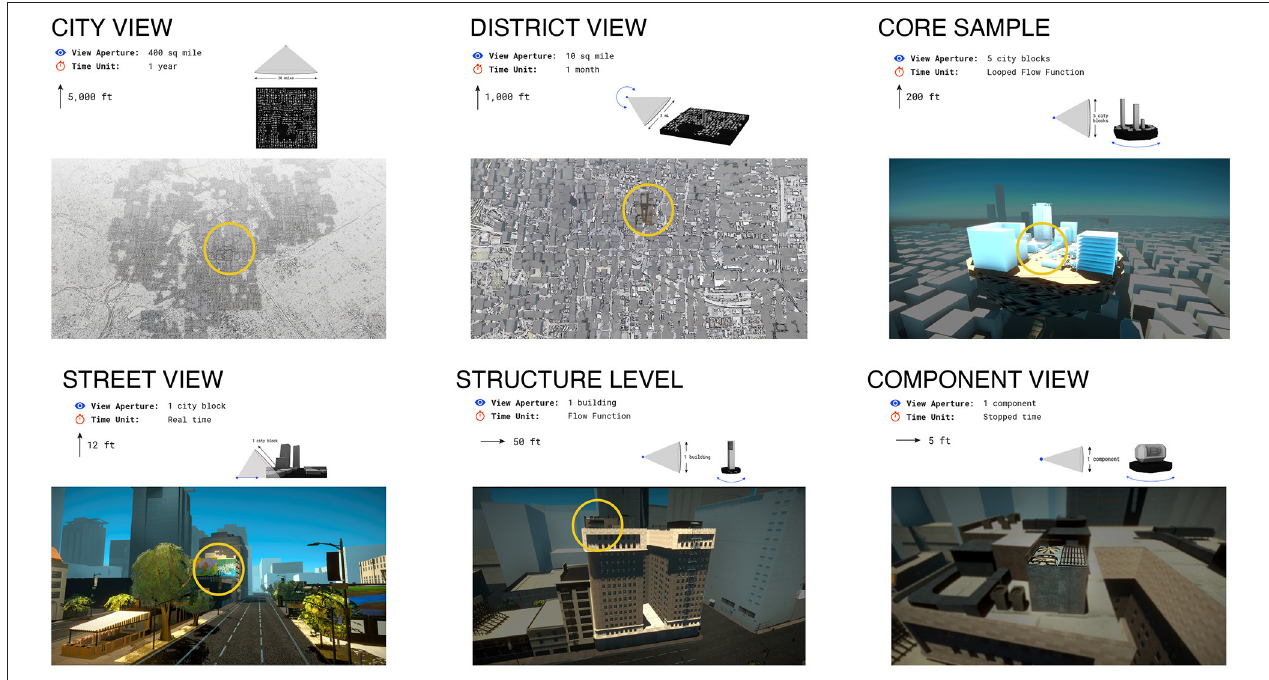
FIGURE 3 | The city was assessed, investigated, developed and refined across scales. Multi-functional transit corridors, for example, have to function both at city scale as well as at ground level. Designing, refining and iterating continually across scales allowed for deeper exploration of trans-scalar impact ( ASCE and Experimental Design, 2020